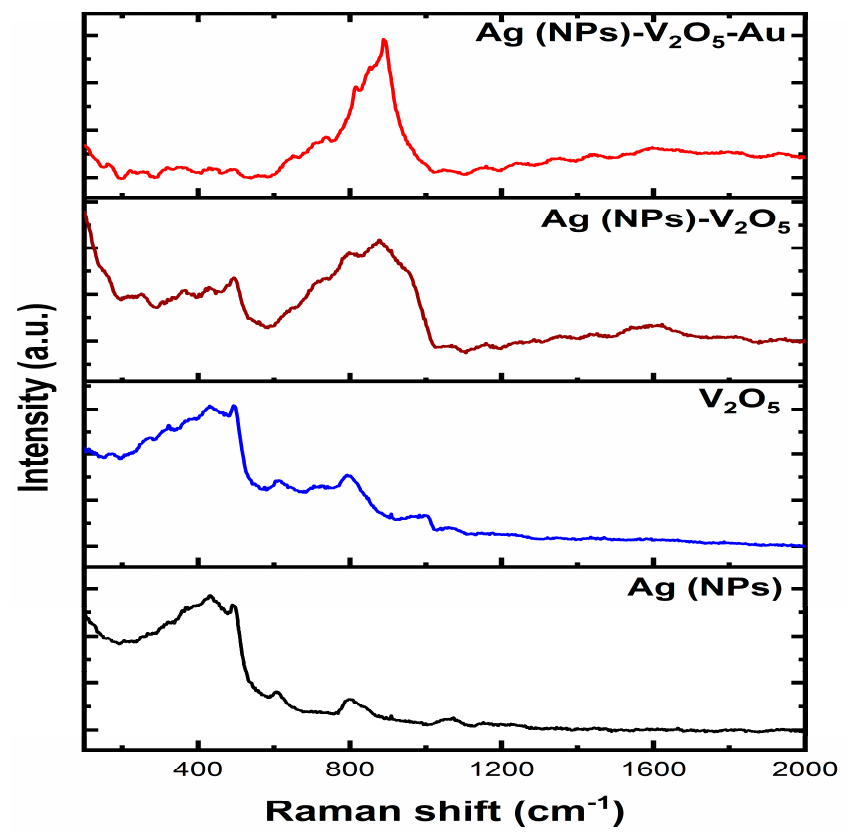
Figure 3. Raman of as-deposited Ag thin fi lm, Ag NPs, Ag NPs/V 2 O 5 thin fi lm, and Ag NPs/V 2 O 5 thin fi lm/Au NPs.